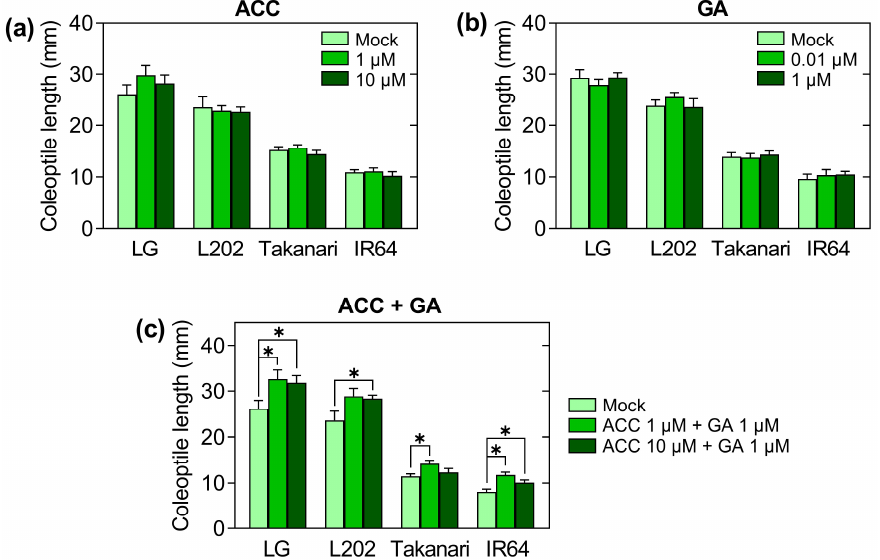
Figure 3. The effect of growth-promoting hormones on coleoptile elongation under oxygen depri- vation in rice varieties with and without anaerobic germination tolerance. Seeds were incubated under 12 h light and 12 h dark cycles for 5 days in deoxygenated water containing an ethylene pre- cursor, 1-aminocyclopropane-1-carboxylate (ACC) ( a ), gibberellic acid (GA) ( b ), or a mixture of both ( c ). Data represent means ± SE ( n = 20). Asterisks indicate a significant difference between mock and hormone-treated samples (* p < 0.05; t -test).